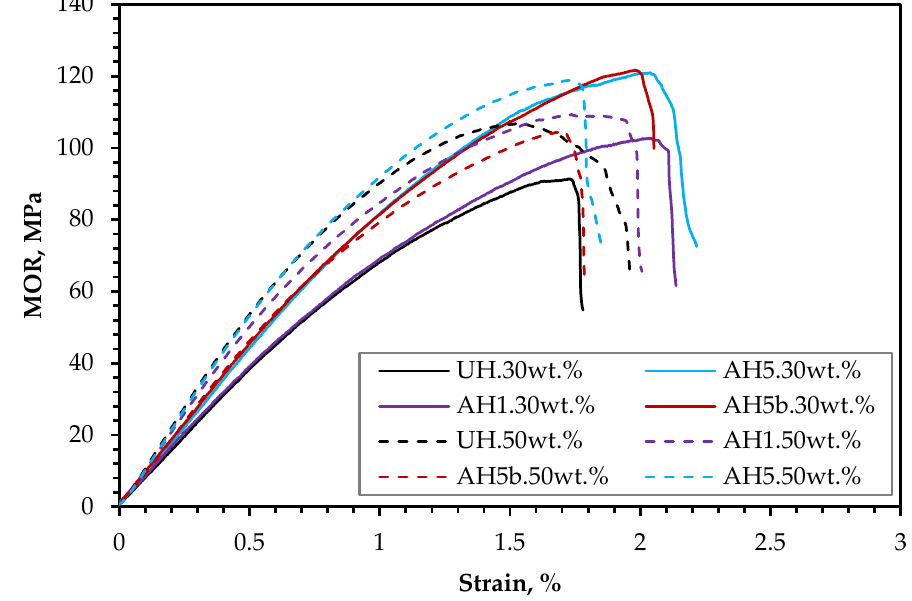
Figure 10. Flexural stress–strain curves of the biocomposites at 30 (–) and 50 wt.% (- -) fiber content.